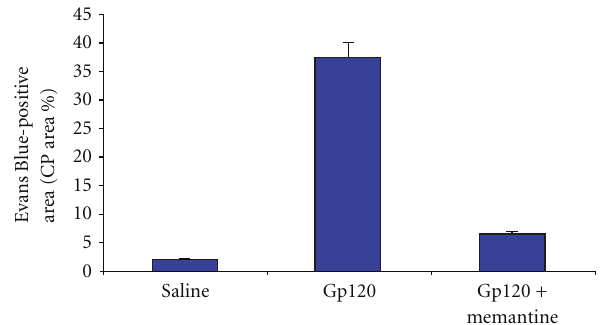
Figure 6: NMDAR-1 activation plays a role in gp120-induced BBB injury. The potential involvement of NMDA in the BBB disturb- ances induced by gp120 was studied using memantine, a NMDA receptor antagonist. Injection of memantine (30mg/kg) before (i.v.) injecting EB, followed by intra-CP gp120, limited the extent of the EB-positive